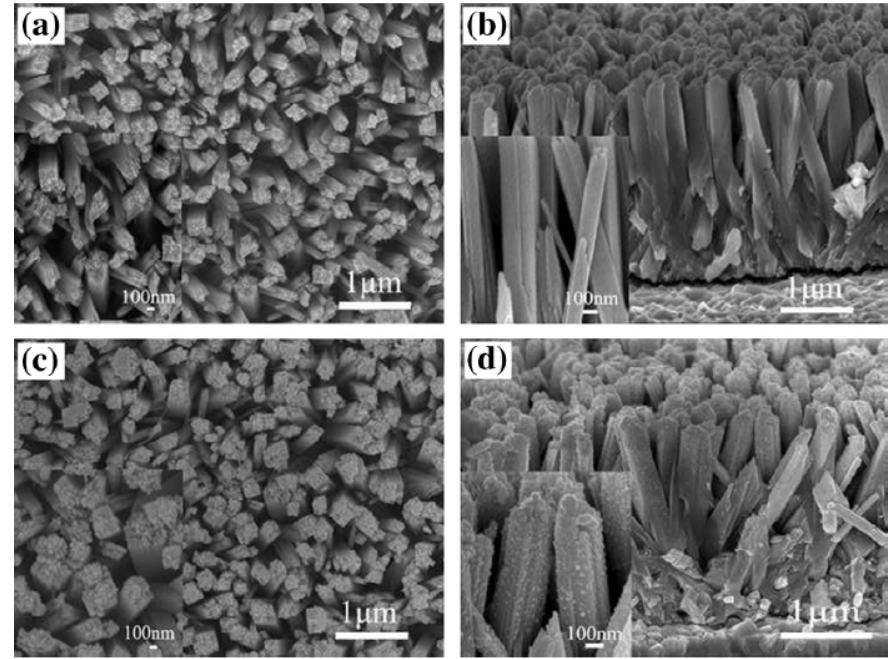
Figure 16. Field ‐ emission scanning electron microscope (FESEM) images of ( a ) TiO 2 nanorod array (top view); ( b ) cross ‐ sectional SEM image of TiO 2 nanorod array grown on FTO (fluorinated tin oxide); ( c ) top and ( d ) cross ‐ sectional view of CdS quantum dots coated TiO 2 nanorod array [68].